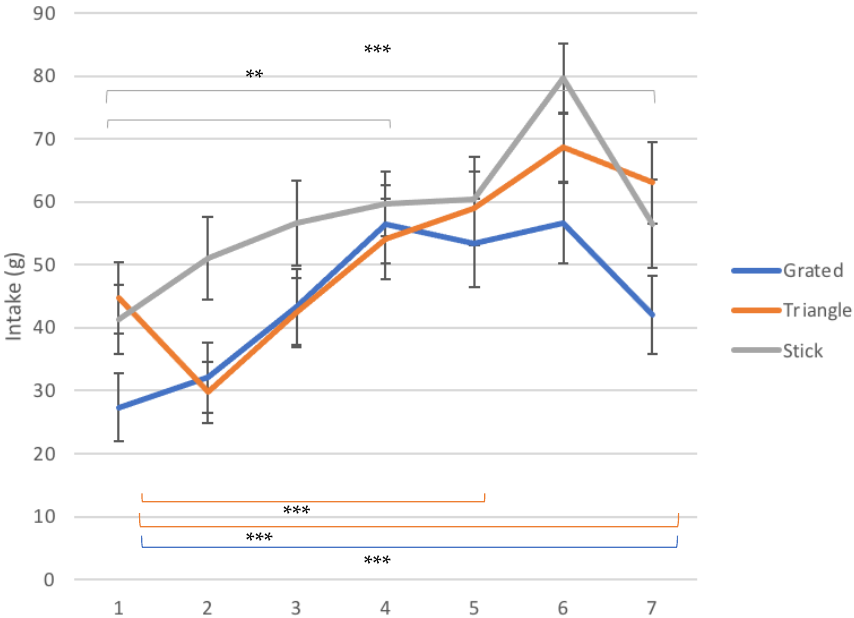
Figure 3. Mean intake scores ± SEM in g of daikon at the different exposure sessions for the three exposure groups. The significance of the differences between selected sessions are depicted for all exposure groups. The group that received daikon cut in triangles and sticks showed a significantly higher intake at the 7th exposure compared to the 1st one, while for the group that received grated daikon the intake at the final exposure was not significantly higher than the initial one. The detailed differences and their statistical significance are given in text. Significance levels: *** p ≤ 0.001, ** p ≤ 0.01.